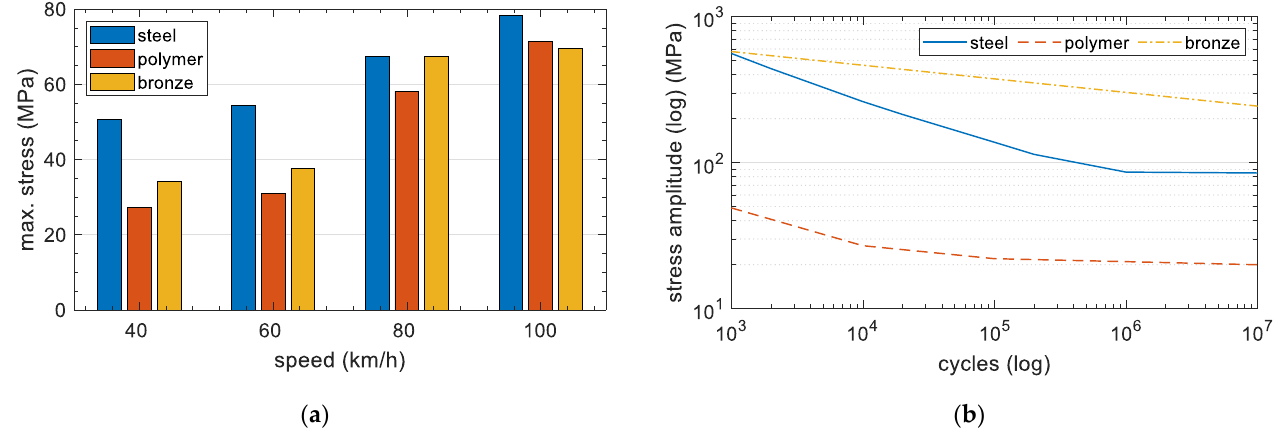
Figure 10. ( a ) Equivalent stress component (Huber-Mises-Hencky) ( b ) S-N curves based on experimental data.